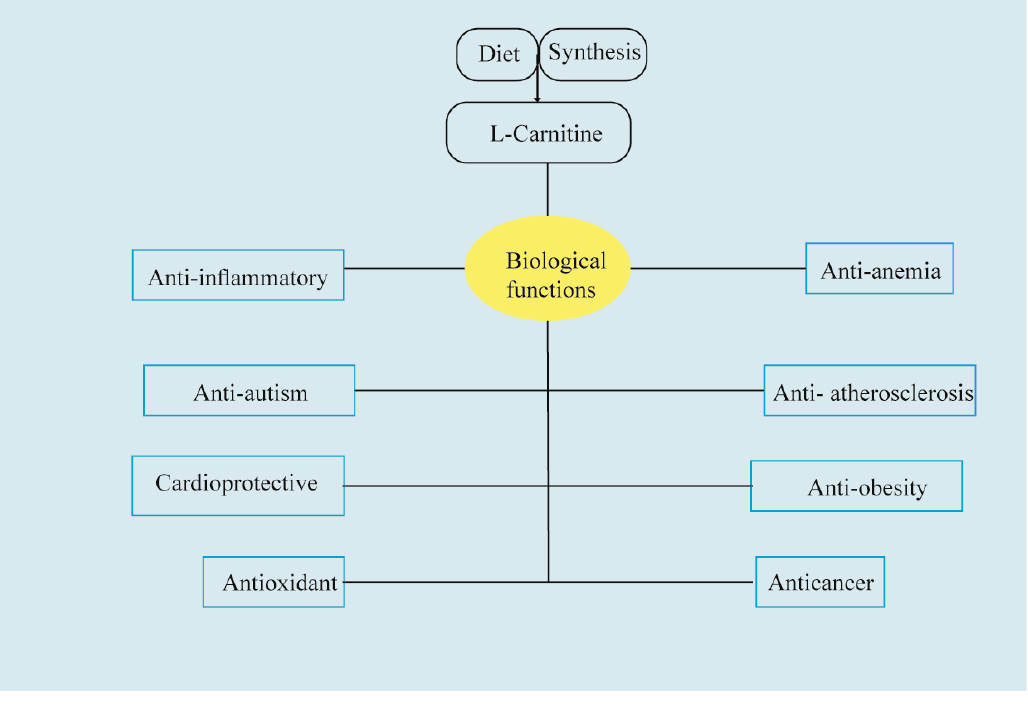
Figure 3. Overview of carnitine biological activities.